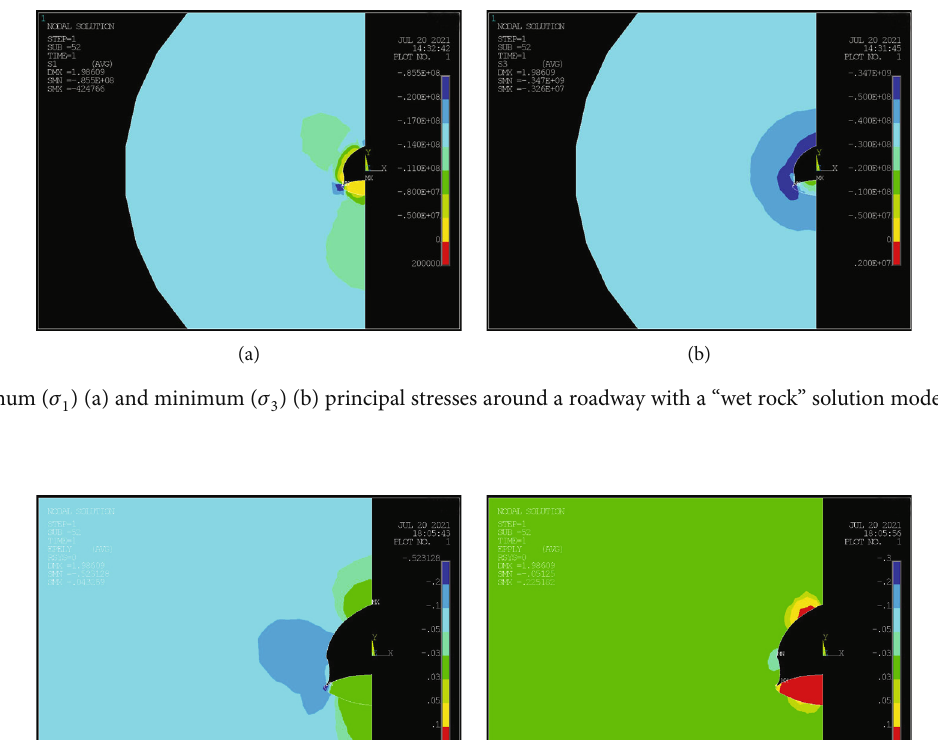
Figure 8: Vertical elastic (a) and plastic (b) strains around the roadway with a “ wet rock ” model (elastic modulus 330